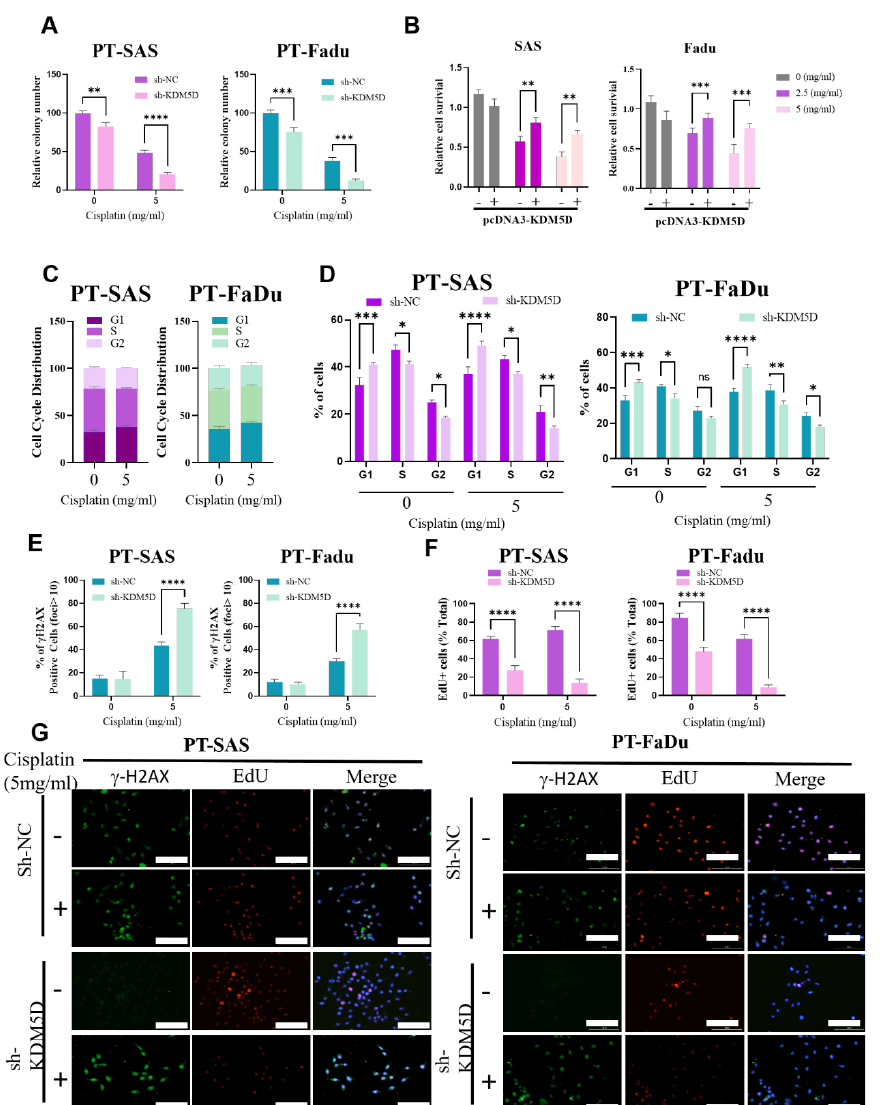
Figure 5. KDM5D abrogates DNA damage and cell cycle arrest upon platinum treatment. ( A ) The suppression of KDM5D expression increased the vulnerability of both PT-SAS and PT-FaDU cells against cisplatin, as indicated by a significant reduction in the number of colonies upon cisplatin treatment. ( B ) Both HNSCC cell lines (SAS and FaDu) with KDM5D overexpression exhibited increased tolerance against several incremental dosages of cisplatin. ( C ) The distribution of the cell cycle did not significantly change after cisplatin treatment in both PT-SAS and PT-FaDU cells. ( D ) KDM5D silencing through shRNA-mediated knockdown induced cell cycle arrest in PT-SAS and PT-FaDU cells, as indicated by an increase in the G1 cell subpopulation and a decrease in the S cell subpopulation. ( E ) The level of DNA damage upon cisplatin treatment was significantly increased in response to KDM5D silencing, as indicated by the percentage of γ H2AX positive cells with >10 foci in both PT-SAS and PT-FaDu cells. ( F ) Cellular proliferation was significantly reduced following KDM5D silencing and become more suppressed after cisplatin treatment, as reflected by decrease in EdU-positive cell fraction in both PT-SAS and PT-FaDu cells. ( G ) Representative immunofluorescence images describe differential expression of DNA damage marker, γ H2AX and proliferation marker, EdU following KDM5D knock-down and cisplatin treatment. Silencing of KDM5D markedly increased the expression of γ H2AX but reduced that of EdU in both PT-SAS and PT-FaDu cells, suggesting a protective role of KDM5D to attenuate cisplatin-mediated DNA damage. Significance level: * p < 0.05; ** p < 0.01; *** p < 0.001; **** p < 0.0001. Scale bar: 100 µ